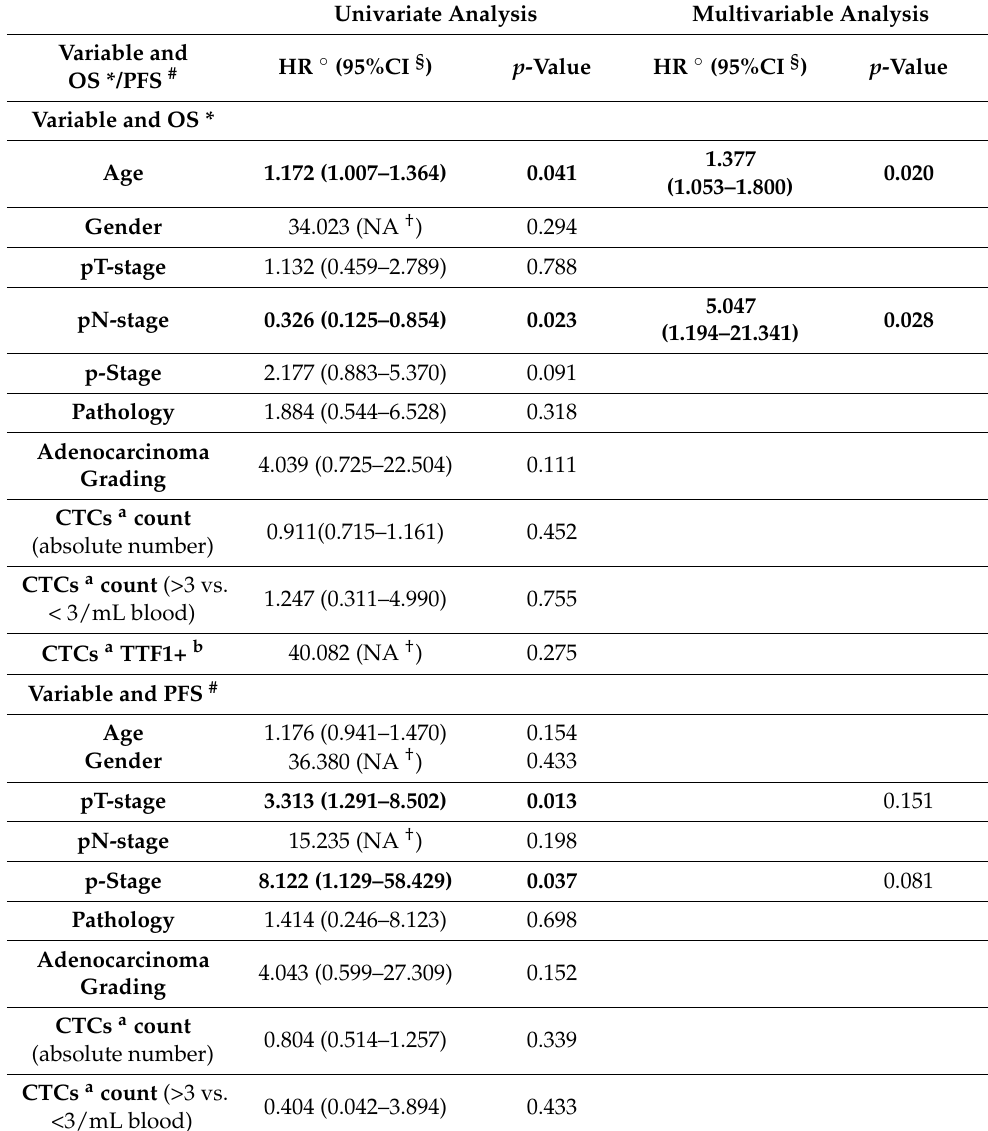
Table 3. Prognostic factors for overall survival and progression-free